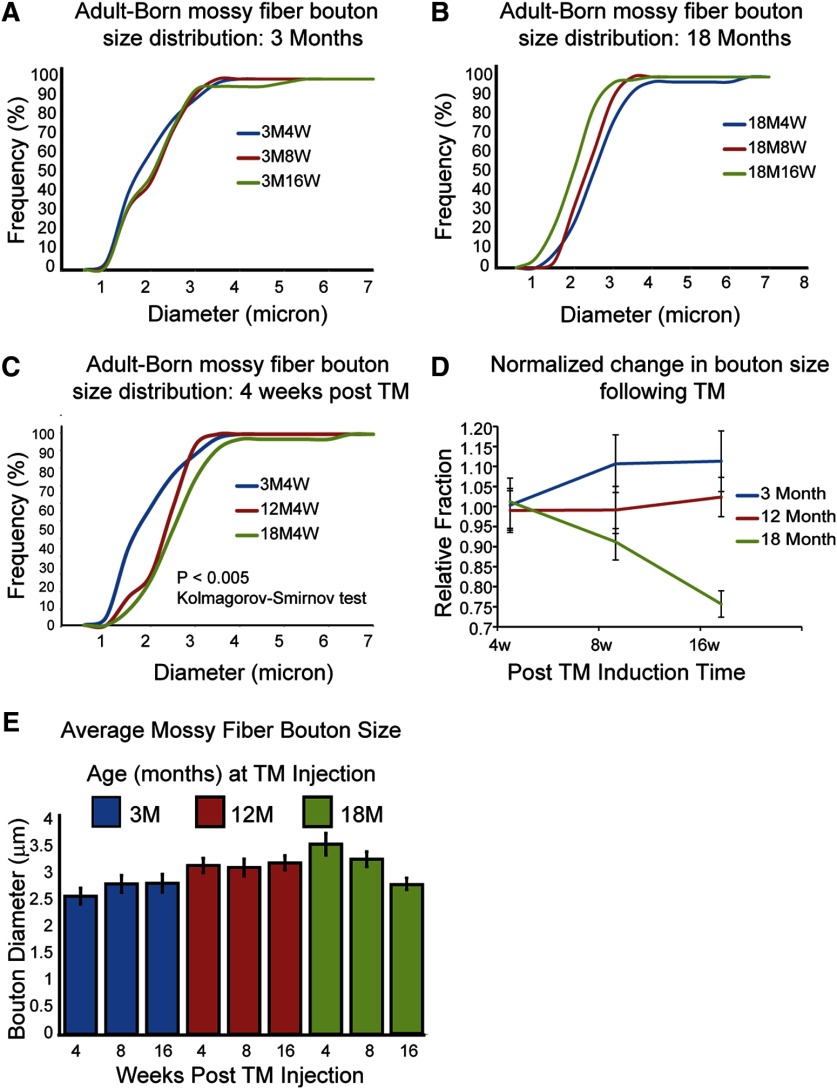
Opposing developmental trajectories in MFB size during adult and aged hippocampal neurogenesis. A, Newborn MFB size distributions in 3 M adult hippocampus, 4W, 8W, and 16W post-TM administration (4 wpi; n = 47, 8 wpi: n = 37, 16 wpi: n = 51). B, Newborn MFB size distribution in 18 M-aged hippocampus, 4W, 8W, and 16W post-TM administration (4 wpi: n = 38, 8 wpi: n = 28, 16 wpi: n = 62). C, Comparison of the relative newborn MFB size distribution 4W post-TM administration in 3-M-, 12-M-, and 18-M-old animals. Note the significantly smaller size distribution in 3 M animals relative to 12 M and 18 M animals (p < 0.005 Kolmogorov–Smirnov test). D, Developmental changes in MFB size occurred in opposite directions between 3 M and 18 M brain. Changes in average size plotted relative to 4W post-TM show increases in MFB size in 3 M but decreases in 18 M animals. Average MFB size remained relatively unchanged in 12 M animals. E, Averaged MFB sizes. The size is determined by measuring the diameter of each MFB. Values in D, E are mean ± SEM.